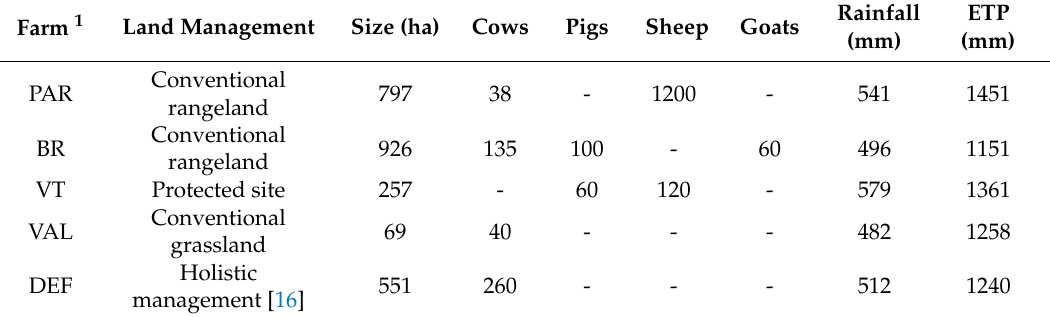
Table 1. Main characteristics of the rangeland farms studied in Extremadura. ETP: Potential evapotranspiration. The names of the farms have been replaced by their